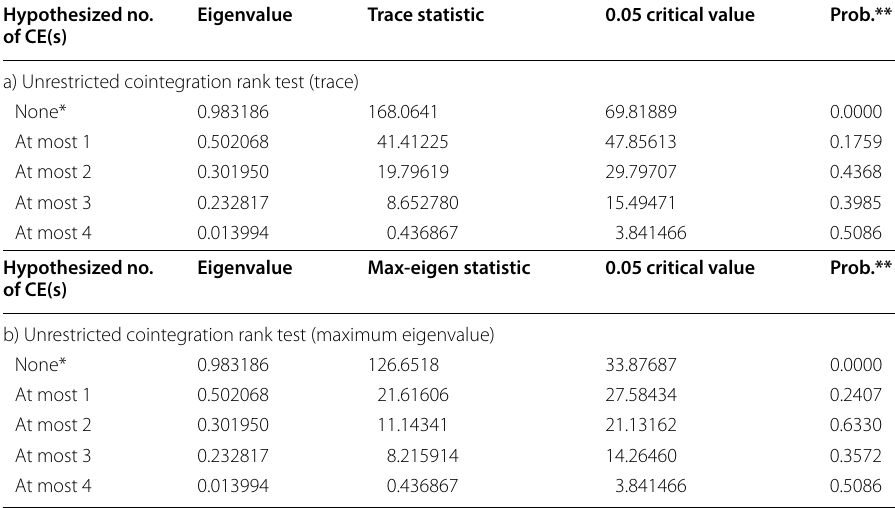
Trace test indicates 1 cointegrating eqn(s) at the 0.05 level Max-eigenvalue test indicates 1 cointegrating eqn(s) at the 0.05 level *Denotes rejection of the hypothesis at the 0.05 level **MacKinnon–Haug–Michelis (1999) P values